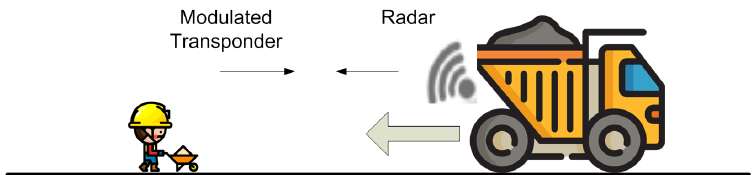
Figure 3. Worker carrying a transponder and a heavy vehicle moving backward equipped with a